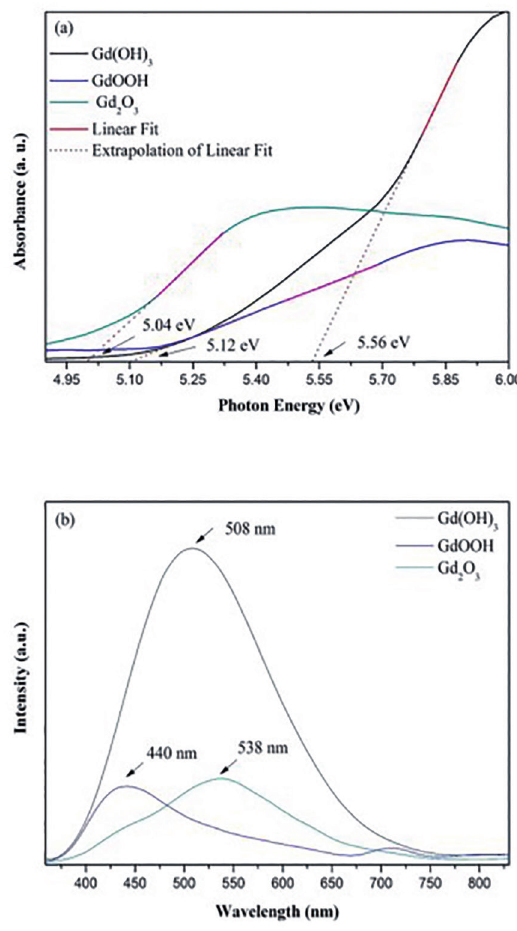
Figure 4: (a) Diffuse reflectance spectra of nanorods and (b) PL at room